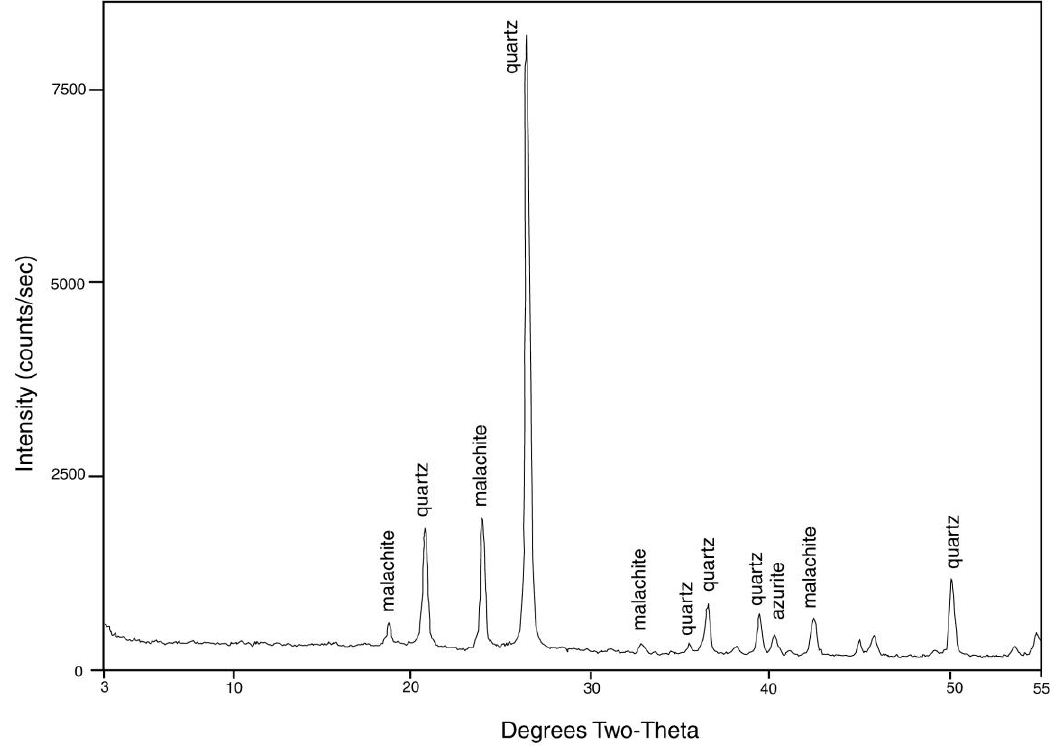
Figure 22. XRD pattern of “colla wood” from Turkey. Cu K-alpha radiation.